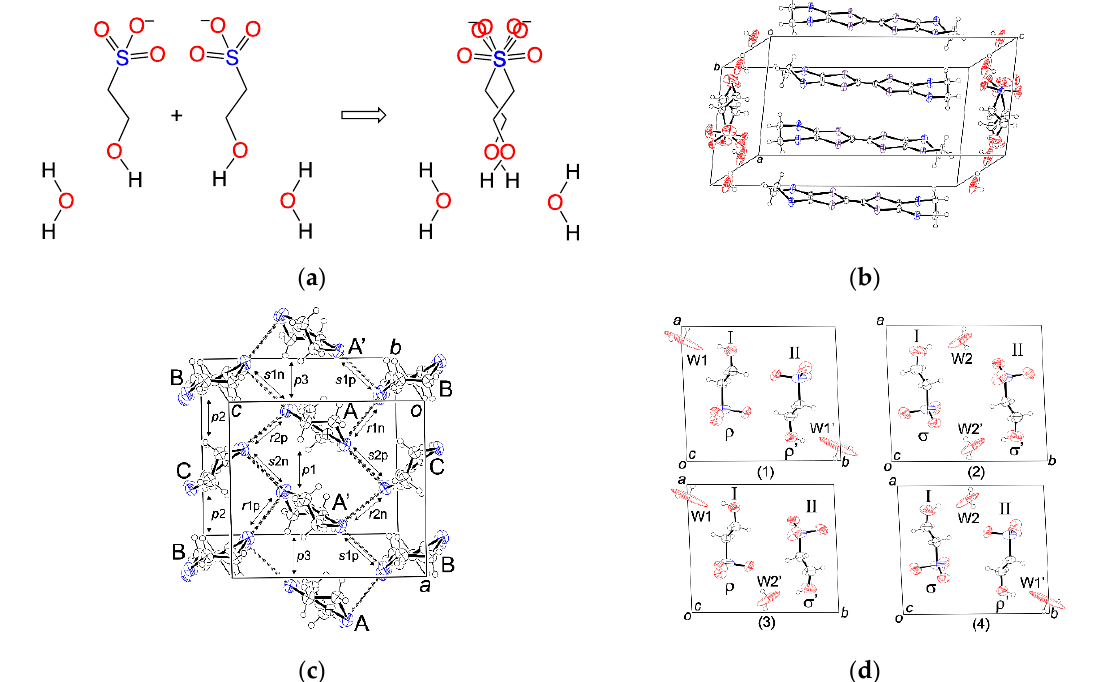
Figure 3. ( a ) A schematic diagram of the disorder of the isethionate anion. ( b ) Crystal structure. ( c ) Arrangement of the donor layer, in which donors A, B and C are crystallographically independent and A (cid:48) is the centrosymmetrically inverted A. Dashed lines indicate short S ··· S, Se ··· S and Se ··· Se contacts ( < 3.70, 3.75 and 3.80 Å, respectively). Transfer integrals are labelled as p 1, p 2, etc. ( d ) Four possible patterns of the donor layer of 3 . The unit cell has two disordered water molecules (W1 and W2) and two isethionate anions (I and II), the latter of which are disordered over two conformations ( ρ and σ ) as schematically shown in Figure 3a. ρ (cid:48) and σ (cid:48) are the symmetrically inverted ρ and σ